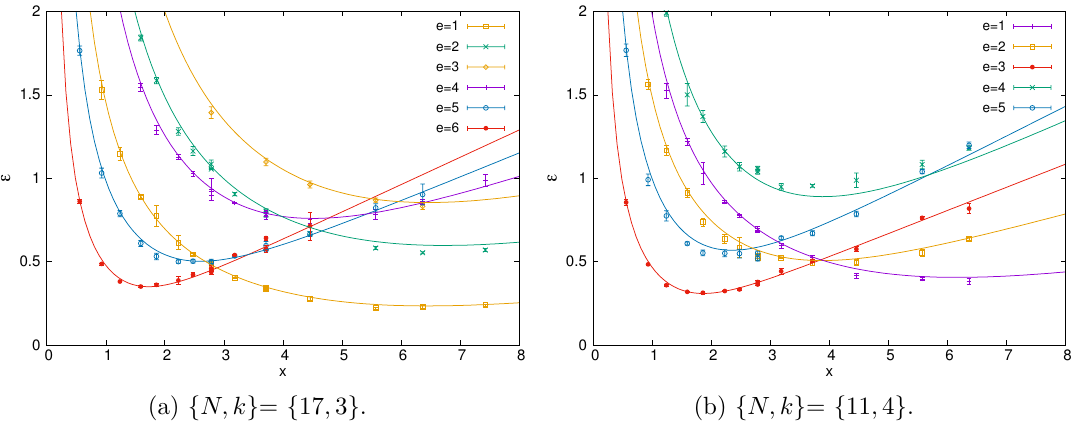
Figure 2. The x -dependence of the torelon energies for states with electric (cid:13)uxes ( e; 0) for f N; k g = f 17 ; 3 g (left) and f N; k g = f 11 ; 4 g (right). The continuous lines are given by eq. (3.6) with (cid:31) 0 = 0 : 6, p and (cid:27) 0 =(cid:21) = 0 : 213.